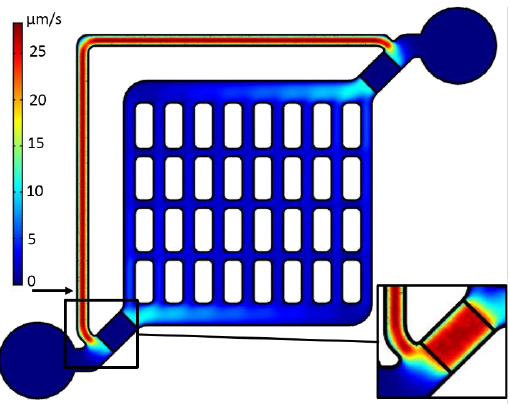
Figure 2. 3D-COMSOL ® simulations of the velocity distribution in the center plane of the microfluidic structure with sealed-off medium inlets and outlets (lower left and upper right circular structures). The velocity field was calculated assuming a volume force of 31.1 N·m −3 induced in the ETµP volume, which was confined by the pump-field electrodes (see Figures 1B and 3). Arrow: site of tracer-particle measurements in the flow-return path. Insert: Velocity profile in the center plane of the ETµP, 125 µm above the